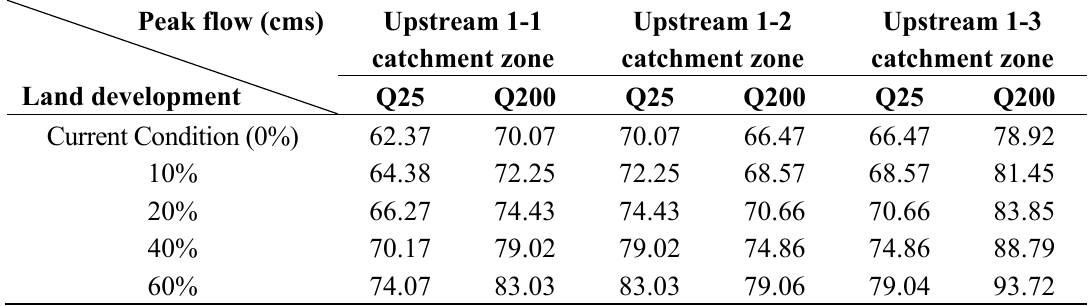
Table 3. Q25 and Q200 peak flow volumes for different levels of land development in the upstream catchment area of the Po Cheng Keng Stream.